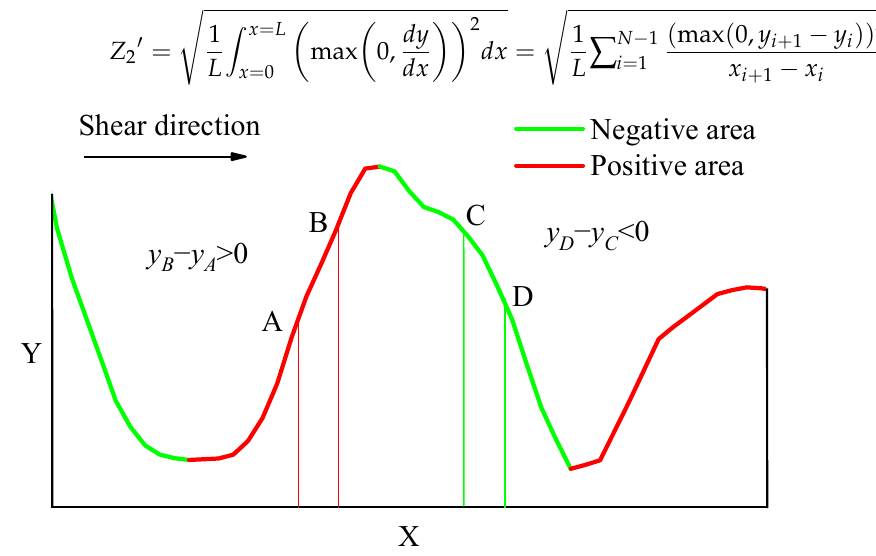
Figure 5. Positive and negative areas in the shear direction.